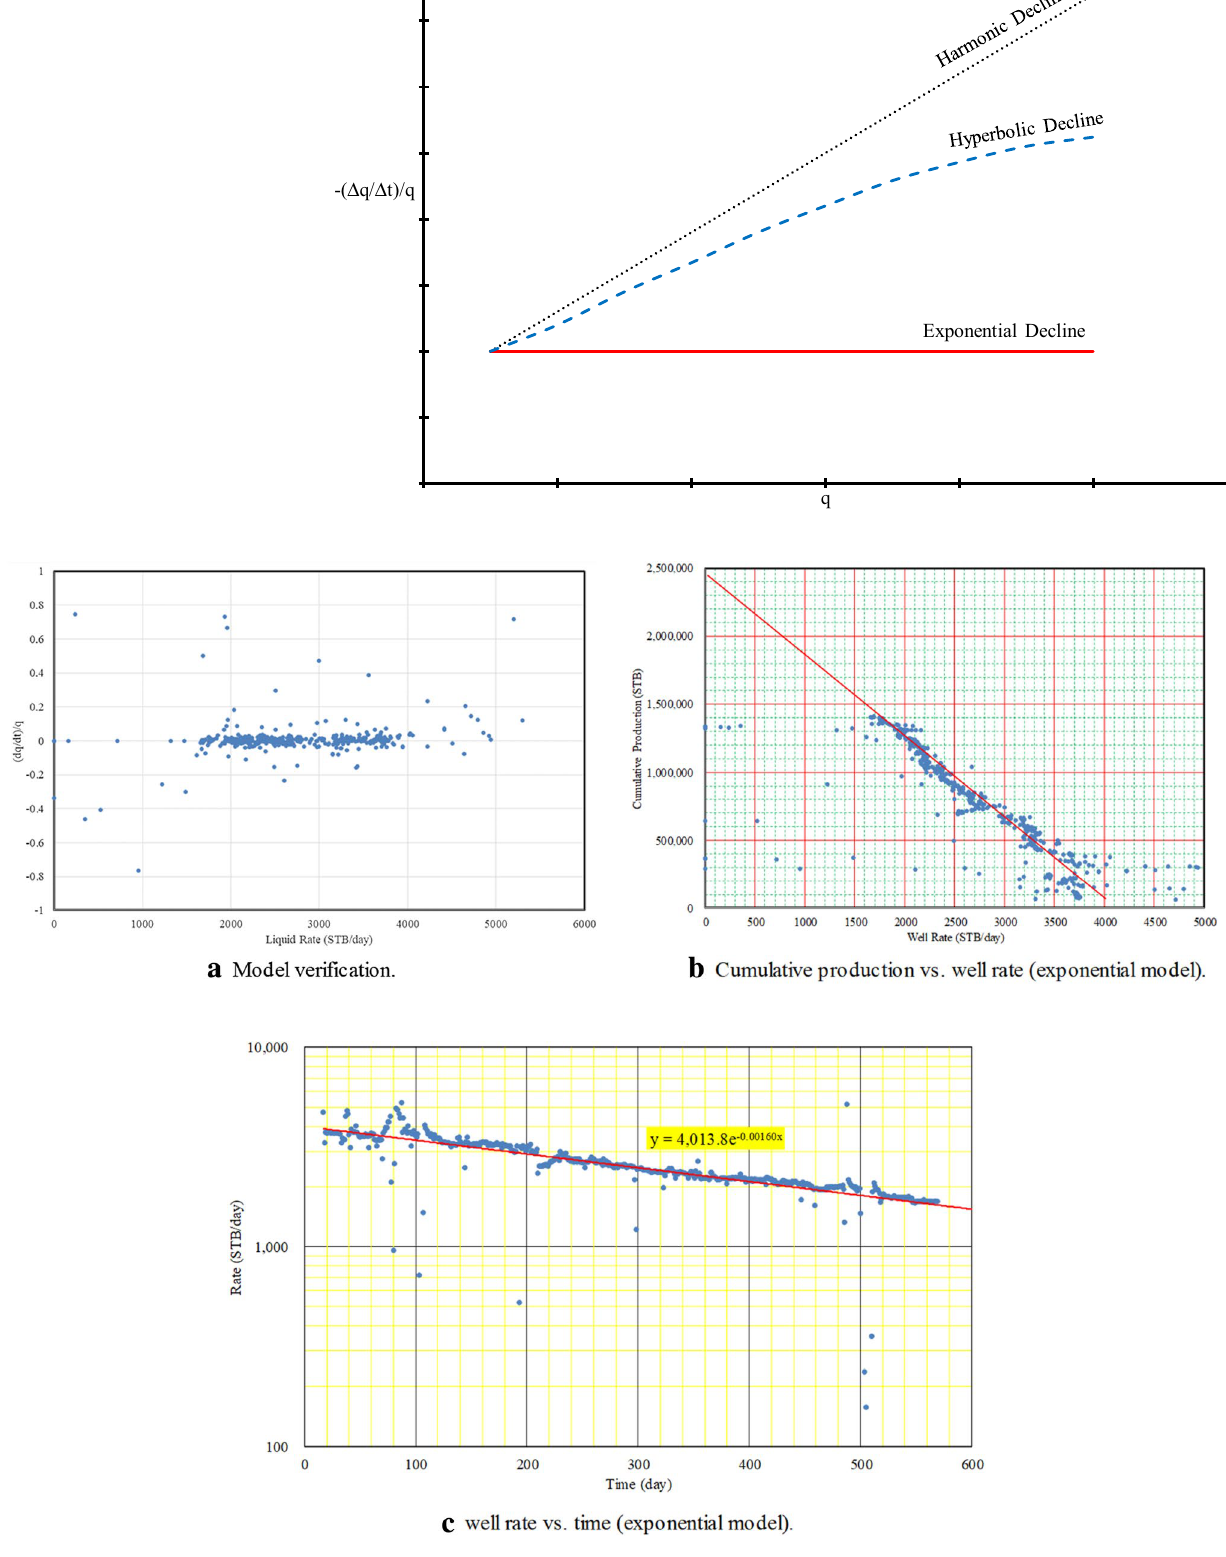
Fig. 2 DCA curves of well producer